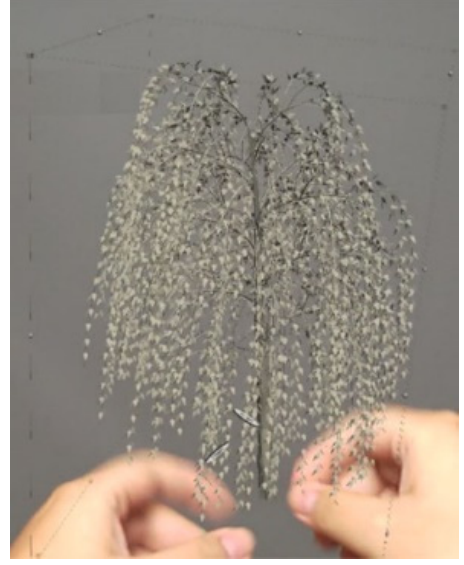
Figure 7. Model registration and position adjustment.